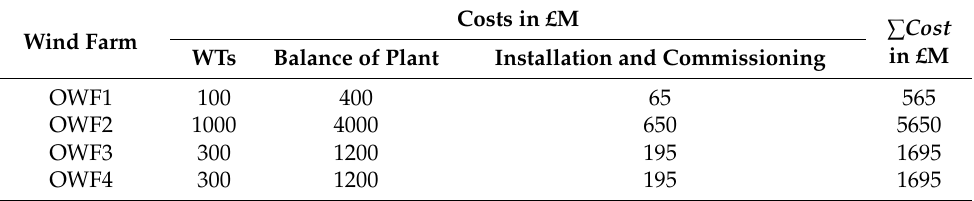
Table 7. Specs of the offshore wind